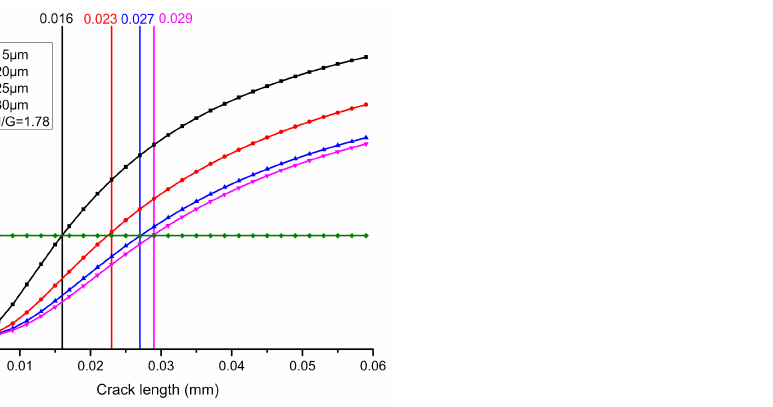
Figure 12. The influence of different solder thicknesses on interfacial crack growth behavior.